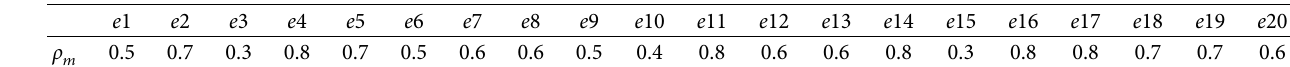
Table 29: .e values of ρ